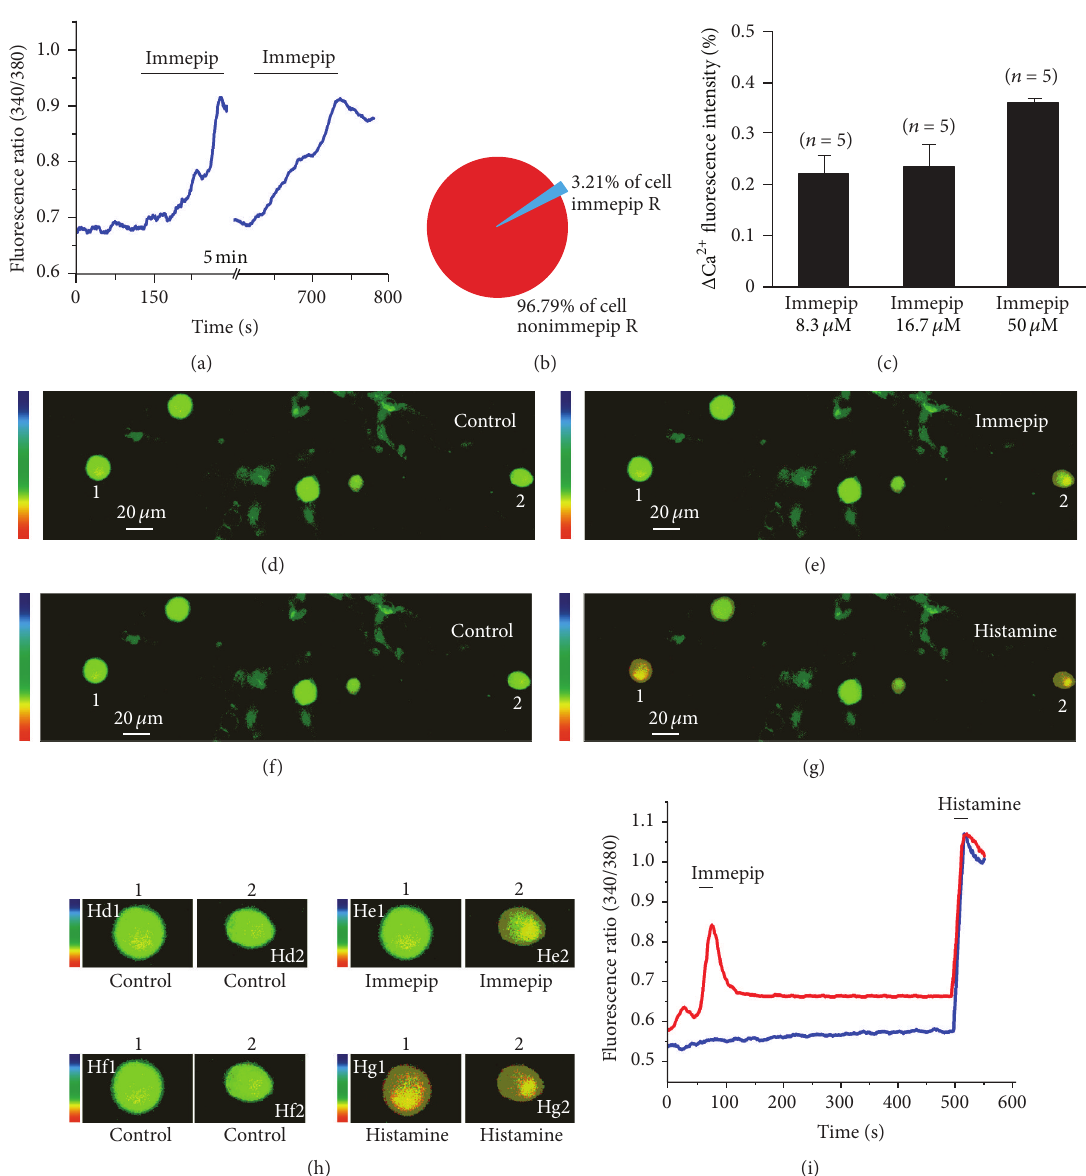
Figure 1: H4 receptor agonist immepip induced an increase in [ Ca 2+ ] i of the DRG neuron. (a) Representative traces of DRG response to H4 agonist 50 𝜇 M immepip twice in 5min interval. (b) Venn diagram of cell shows the proportion of immepip-response DRG neuron in total test neurons. (c) Histograms show that the DRG neuron exhibited a concentration-dependent increase in [ Ca 2+ ] i response to 8.3, 16.7, and 50 𝜇 M immepip stimulation. (d, e, f, and g) Representative neurons response to 50 𝜇 M immepip and 50 𝜇 M histamine, (d) control, (e) neuron 2 increase in [ Ca 2+ ] i by application of immepip, (f) washout, and (g) neurons 1 and 2 increase in [ Ca 2+ ] i by application histamine. (h) Magnified neuron images of the same neurons in (d–g). Images of Hd1, Hd2 were magnified from neurons 1 and 2 in (d); images of He1, He2 were magnified from neurons 1 and 2 in (e); images of Hf1, Hf2 were magnified from neurons 1 and 2 in (f); images of Hg1, Hg2 were magnified from neurons 1 and 2 in (g). (i) Traces of DRG neurons 1 and 2 from (d–g) response to immepip and histamine; the data show both neuron 1 and neuron 2 respond to histamine (blue line), but only neuron 2 responds to immepip (red